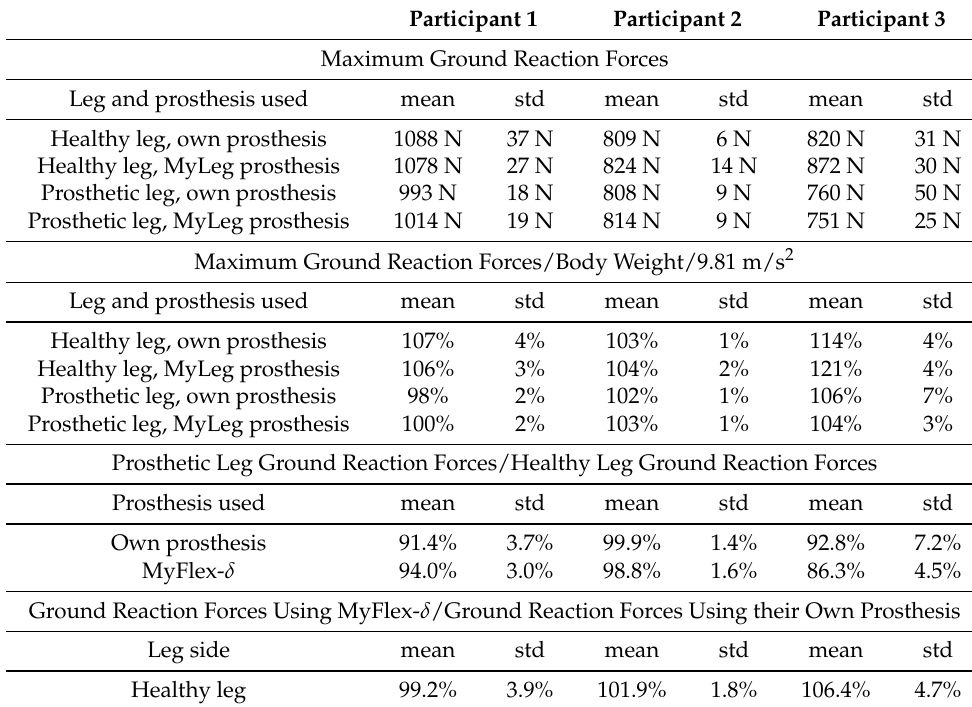
Figure 10. Procedures for the calculation of: ( a ) the ratio between the ground reaction force measured from the prosthetic leg (GRF-PL) and the healthy leg (GRF-HL); ( b ) the ratio between the ground reaction force measured while using MyFlex- δ (GRF-MF) and while using their own prosthesis (GRF-OP). Table 4. Maximum ground reaction forces. Mean values (mean) and standard deviations (std) are calculated from 50 gait